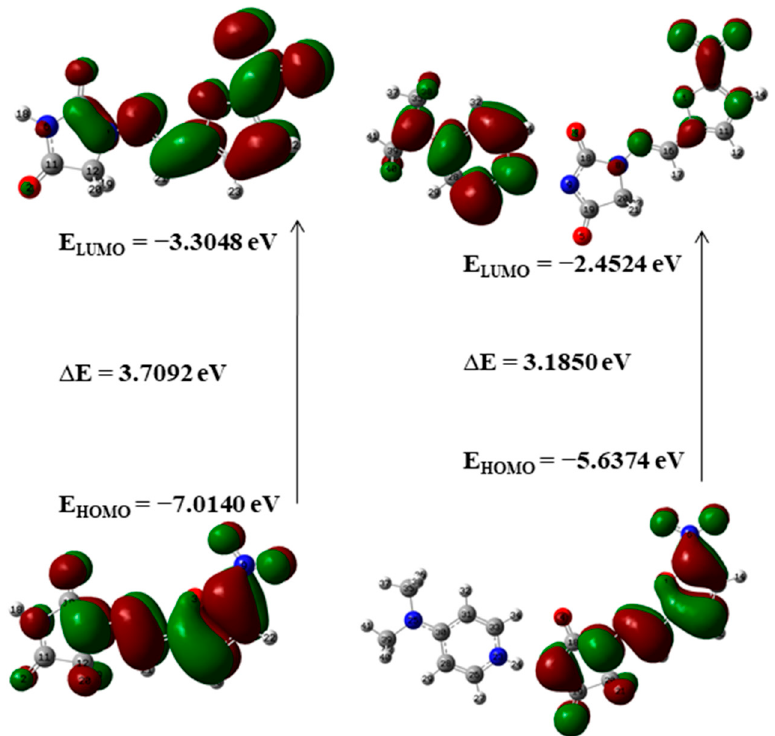
Figure 5. The HOMO-LUMO energy gap of NF and NF-DMAP calculated at the B3LYP level of theory.